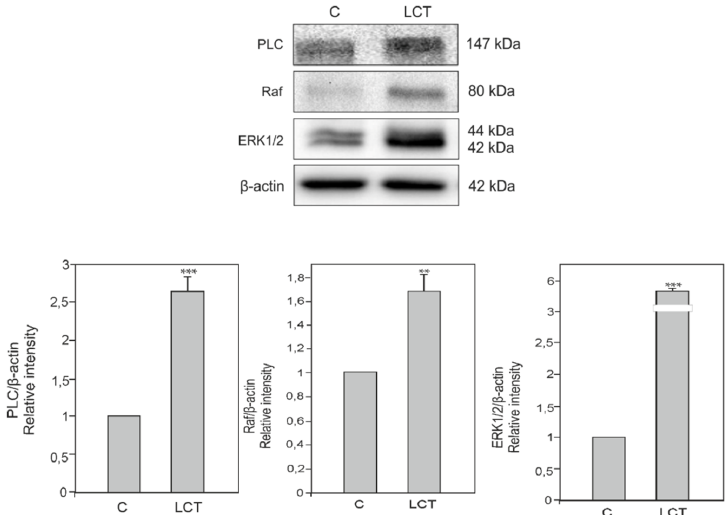
Figure 4. Expression of Phospholipase C (PLC), Kinase Raf (Raf) and Extracellular signal-regulated kinase (ERK) in Leydig cell tumors. Representative blots and relative expression (arbitrary units) of qualitative expression of PLC, Raf and ERK proteins in Leydig cell of control testis (C) and the Leydig cell tumor (LCT). The relative amount of respective proteins normalized to β -actin. Relative intensity of bands from three separate analyses is expressed as means. Asterisks show significant differences between expression of control and treated Leydig cells. Data is expressed as means. Values are denoted as ** p < 0.01 and *** p < 0.001.